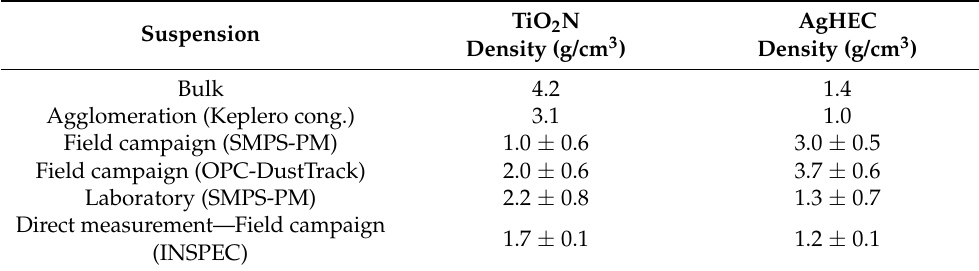
Table 5. TiO 2 N and AgHEC particle densities obtained with different measurement techniques and different atomization processes. Bulk: theoretical raw material density; Agglomeration: highest packing density (Keplero conjecture); Field campaign (SMPS-PM): density values obtained considering the particle mass collected on filters and volumetric aerosol size distribution at the field campaigns; Field campaign (OPC-DustTrack): particle density obtained using only OPC particle volumetric size distribution data and real-time mass particle concentration values from DustTrack at field campaigns Laboratory (SMPS-PM): the same as Field campaign (SPMS-PM) but with laboratory-generated aerosols; Direct measurement—Field campaign (INSPEC): single particle density measurement obtained with filters sampled with INSPEC in field campaign.